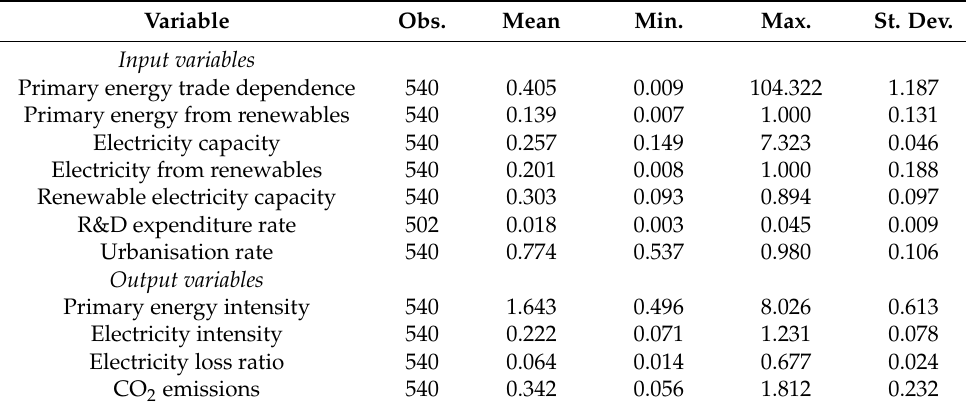
Table A2. Summary statistics for all countries over the entire period.